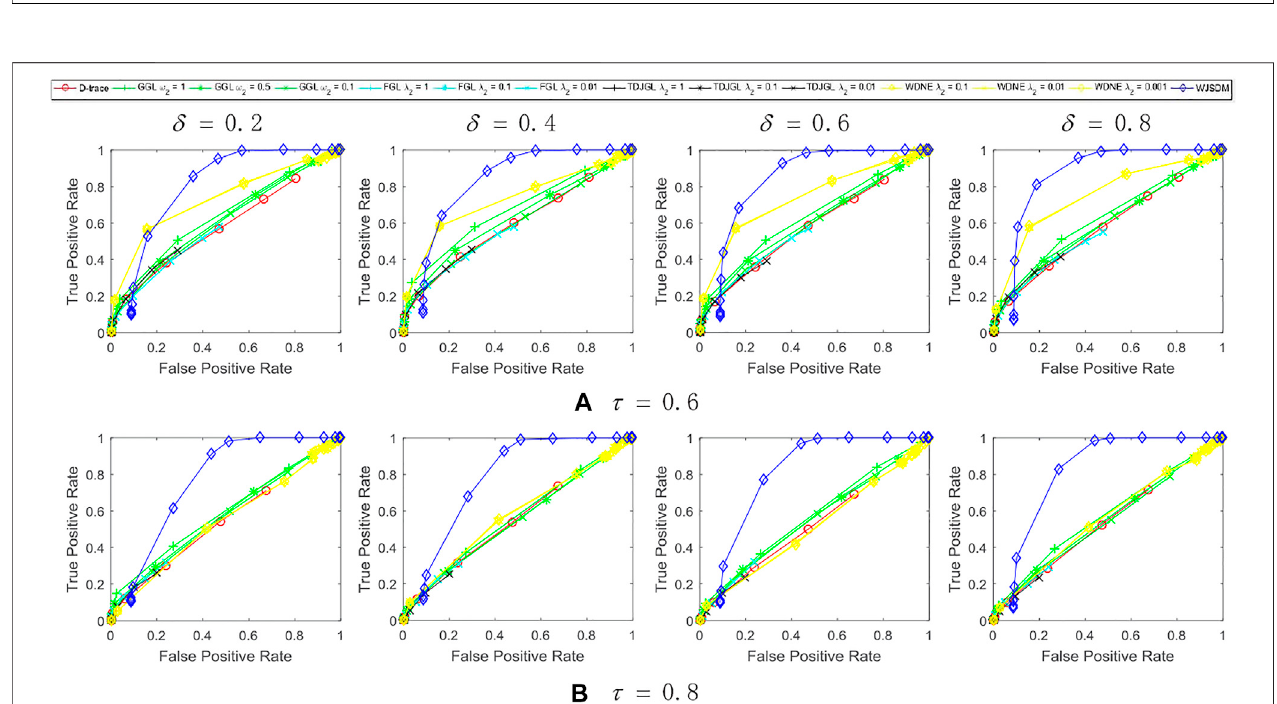
FIGURE3| PerformanceofWJSDM,D-trace,GGL,FGL,TDJGLandWDNEwith p (cid:1) 100, K (cid:1) 3, n (cid:1) 200andmissingrate (A) τ (cid:1) 0.6, (B) τ (cid:1) 0.8.Withineachplot, eachlinepresentstheperformanceofamethodwiththevalueof λ (forWJSDMandD-trace), λ 1 (forFGL,TDJGLandWDNE)or ω 1 (forGGL)varyingfora fi xedvalueof λ 2 (for FGL, TDJGL and WDNE) or ω 2 (for GGL). Each curve is obtained by averaging the performance of a method over ten random generations of data.